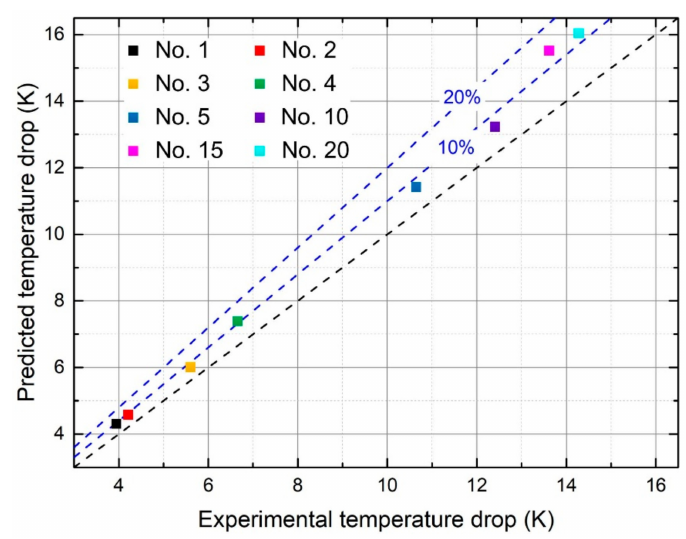
Figure 6. Comparison of numerical predictions with experimental results.